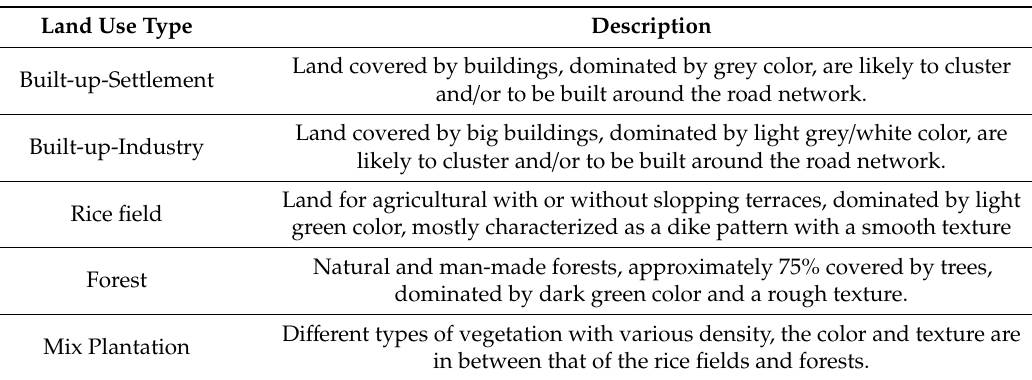
Table 5. Land Use Classification in Study